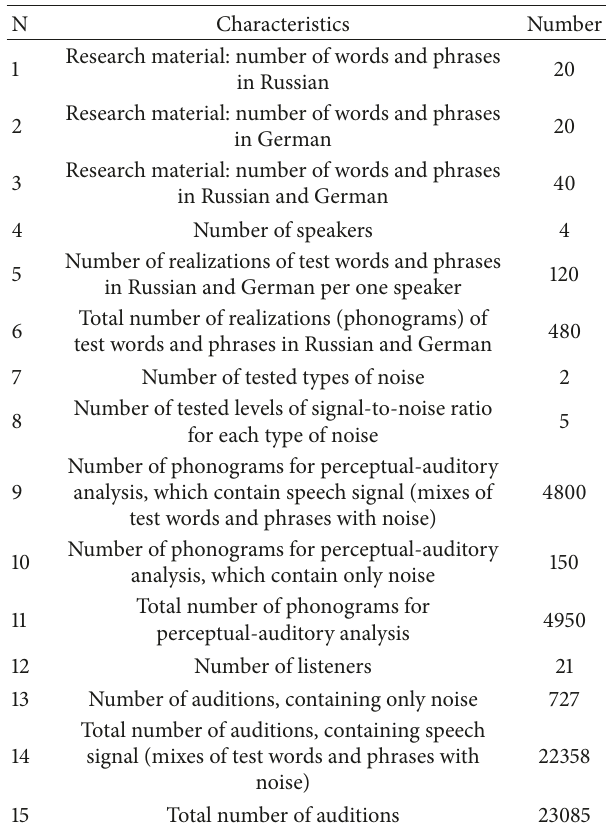
Table 3: Quantitative description of the